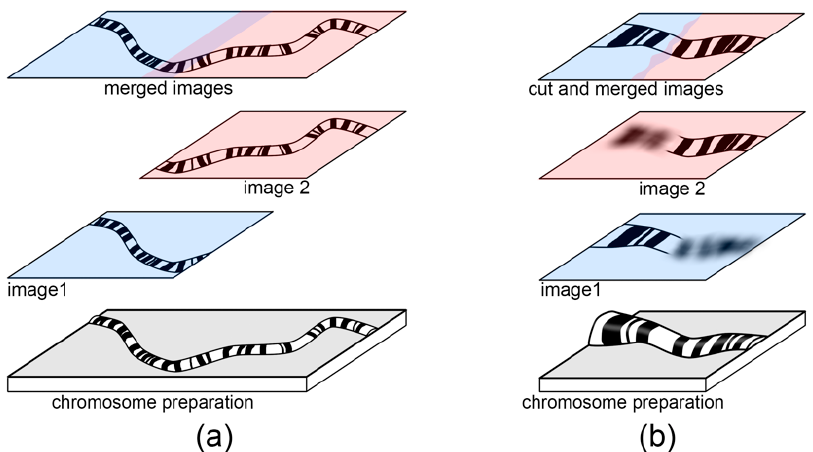
Figure 2. Images merging scheme. ( a ) A chromosome region from a single microscope field; ( b ) a chromosome region in different focal planes. Images 1 and 2 are taken from two different and overlapped microscope fields ( a ) or from two different focal planes ( b ). Merged images performed by a “Merge Layer” function ( a ) or by cutting unfocused fragments of images with a “Lasso Tool” prior to merging layers ( b ). All manipulation tool references relate to Photoshop CS6.